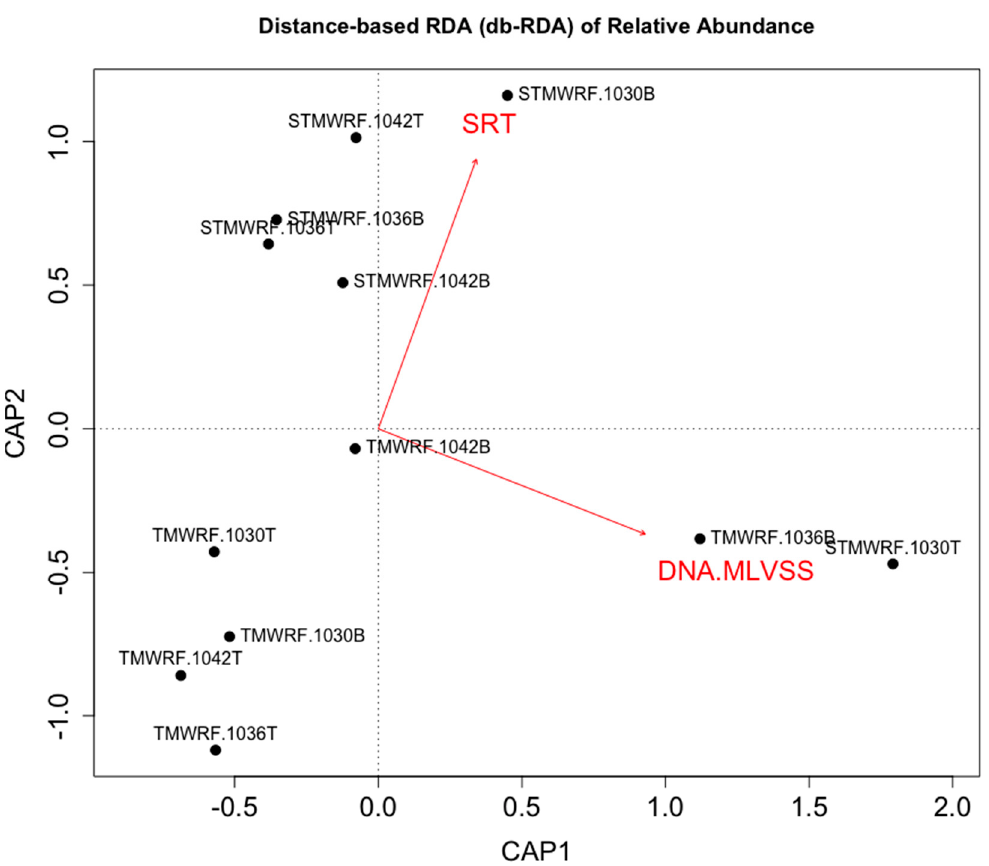
Figure 4. Distance-based redundancy analysis (db-RDA) of microbial enrichment achieved in various sludge fractions (constrained inertia = 42.76%). Enrichment factors were constrained by facility types (TMWRF employing EBPR vs. STMWRF performing conventional treatment). Both facility operational condition (SRT) and sludge characteristic (DNA amount per gram of MLVSS) explained variations in enrichment (SRT: R 2 Adonis = 0.126, P Adonis = 0.085; DNA / MLVSS: R 2 Adonis = 0.302, P Adonis = 0.003).